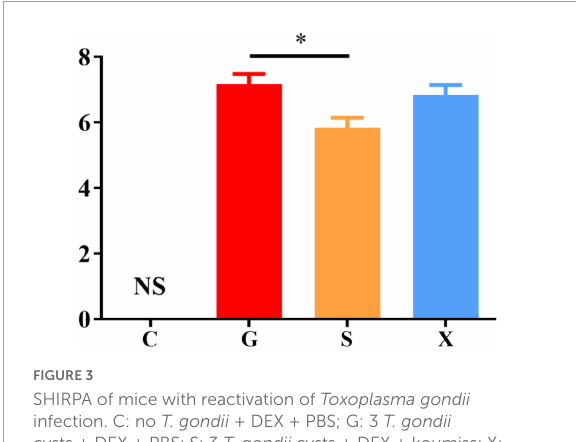
FIGURE3 SHIRPA of mice with reactivation of Toxoplasma gondii infection. C: no T. gondii + DEX + PBS; G: 3 T. gondii cysts + DEX + PBS; S: 3 T. gondii cysts + DEX + koumiss; X: 3 T. gondii cysts + DEX + mare’s milk. All data are expressed as mean ± SD. ∗ P < 0.05 and NS, no